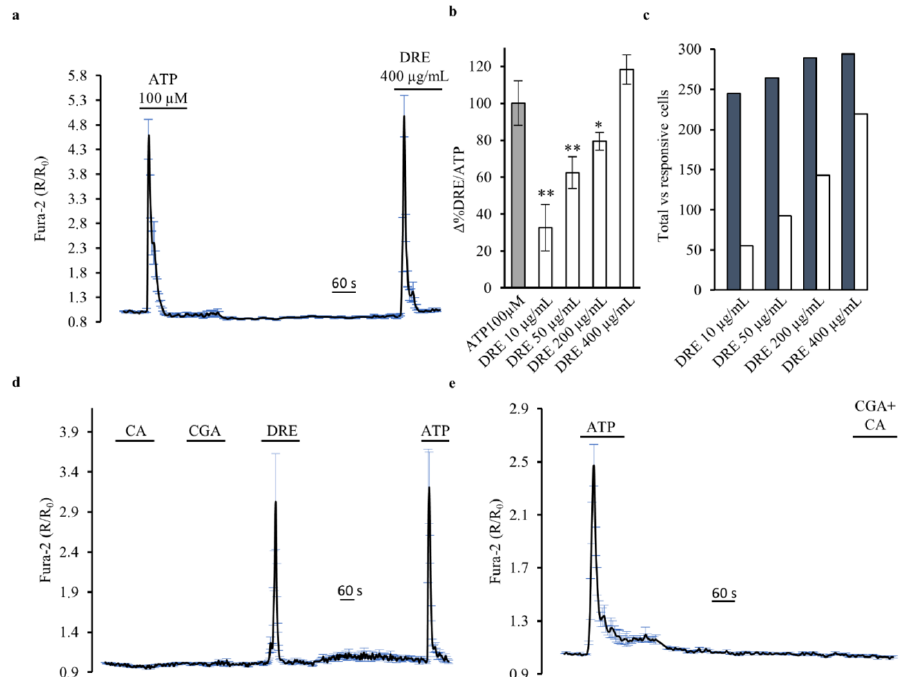
Figure 2. DRE increases intracellular Ca 2+ levels, while caffeic and chlorogenic acids do not, as measured by Fura-2 in single HEK293 cells. ( a ) Response of Fura-2-loaded HEK293 cells to the Ca 2+ -mobilizing agonist ATP (100 µ M) compared with the Ca 2+ increase elicited by DRE (400 µ g/mL). The reported values are means ± SE from all the responsive cells on a single coverslip. ( b ) Changes in the Fura-2 ratio in Ca 2+ -containing solutions in response to increasing doses of DRE (10, 50, 200, and 400 µ g/mL) normalized to the response induced by ATP. The reported values are means ± SE from all the responsive cells of all experiments performed (** p < 0.01 vs. ATP, * p < 0.05 vs. ATP). ( c ) Number of DRE-treated (10, 50, 200, and 400 µ g/mL) Ca 2+ -responsive cells versus the total number of cells analyzed. The bar graph summarizes the number of cells of all the experiments performed for each concentration. ( d ) Response of Fura-2-loaded HEK293 cells to caffeic acid (CA, 150 µ M), chlorogenic acid (CGA, 200 µ M), and DRE (400 µ g/mL) compared with the effect induced by the Ca 2+ -mobilizing agonist ATP (100 µ M). The reported values are means ± SE from all the responsive cells on a single coverslip. ( e ) Response of Fura-2-loaded HEK293 cells to the simultaneous exposure to caffeic (CA, 150 µ M) and chlorogenic acid (CGA, 200 µ M) compared with the effect induced by the Ca 2+ -mobilizing agonist ATP (100 µ M). The reported values are means ± SE from all the responsive cells on a single